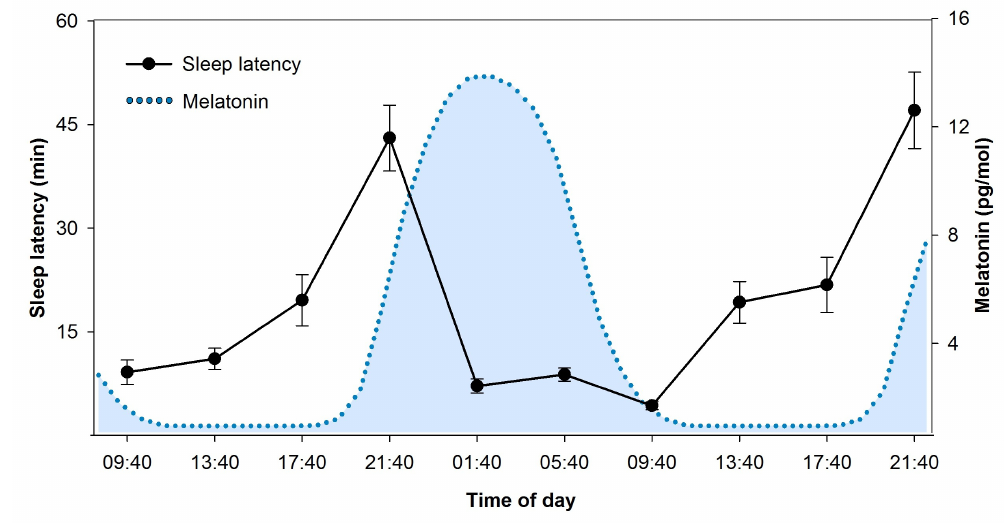
Figure 2. Time course of sleep latency over the 24-h cycle in a 40-h nap protocol. Sleep latency to sleep stage 1, assessed during regular naps of 80 min (NP, see [49] for details), shows a striking circadian pattern. Longest durations occur in the evening hours shortly before habitual bedtime and mirror highest levels of circadian wake promotion at the end of the biological day [27]. Shortest durations were measured during the biological night, which is illustrated by the blue dotted curve of melatonin secretion. Melatonin was analyzed in saliva samples collected in the same study [12,49] and modelled according to algorithms published in